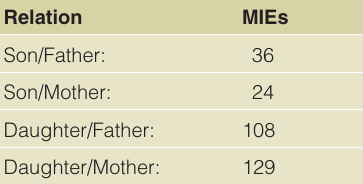
Table 3. Mendelian Inheritance errors as estimated by direct parent/offspring relations.